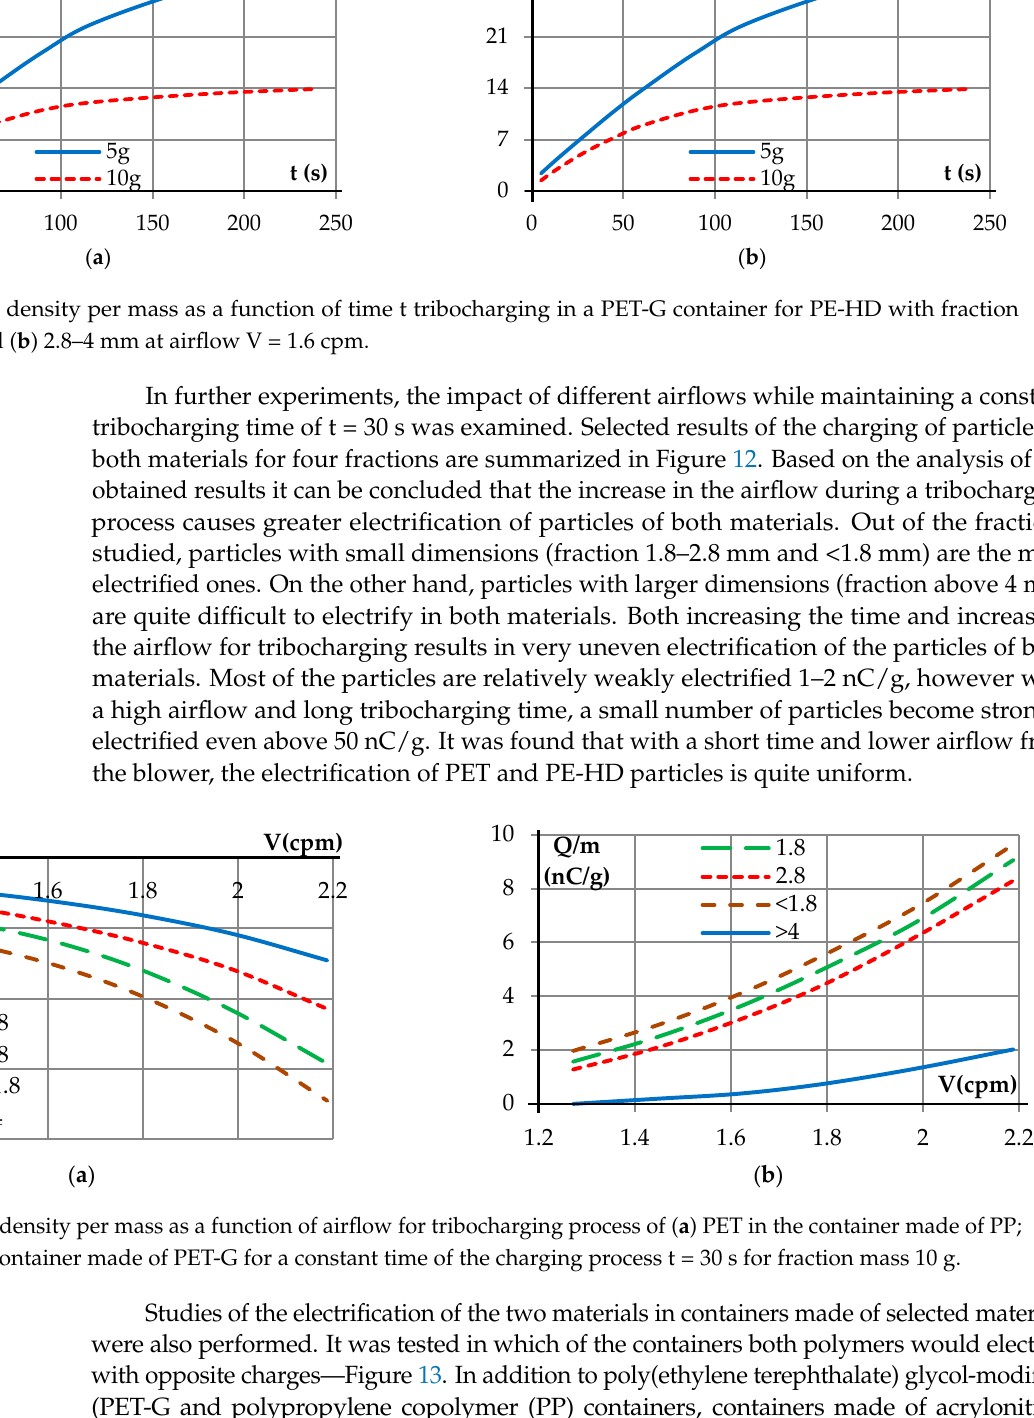
Figure 10. Charge density per mass as a function of time t of tribocharging in a container for PET with fractions ( a ) 1.8–2.8 mm and ( b ) 2.8–4 mm at airflow V = 1.6 cpm.